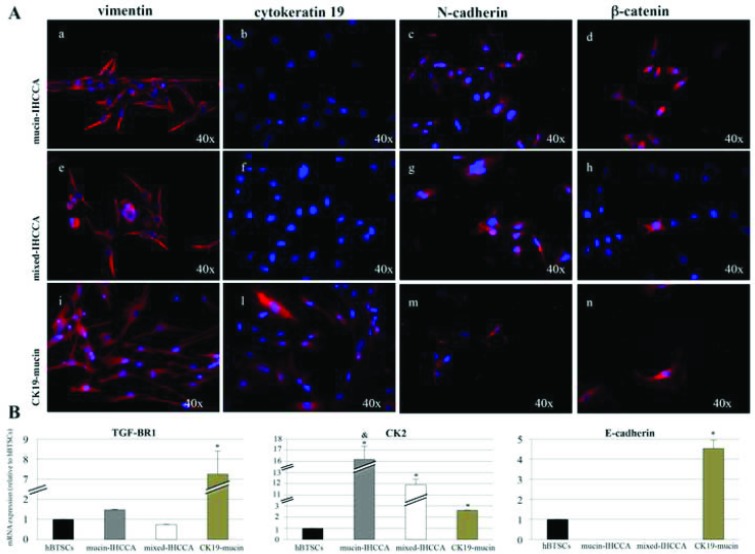
Immunofluorescence (IF) and RT-PCR analyses of primary cell cultures.A: By IF, vimentin was expressed in mucin- (a, red), mixed-IHCCA (e, red) and CK19-mucin (i, red) primary cell cultures. CK19 was only expressed in CK19-mucin primary culture (l, red). N-cadherin was expressed in all three primary cultures (c,g and m, red). β-catenin has nuclear and cytoplasmic localization in primary cultures (d,h and n, red). B: By RT-PCR, CK2 was more expressed in mucin- and mixed-IHCCA than in CK19-mucin cell cultures or hBTSCs while TGF-ΒR1 and E-cadherin genes were more expressed in CK19-mucin. The E-cadherin gene was virtually unexpressed in mucin- and mixed-IHCCA cell cultures. mRNA expression levels were normalized with respect to hBTSCs, considered equal to 1. * = p<0.05 vs other cell cultures; & = p<0.05 vs mixed-IHCCA. Mean +/- SD of N = 3–5 independent experiments.